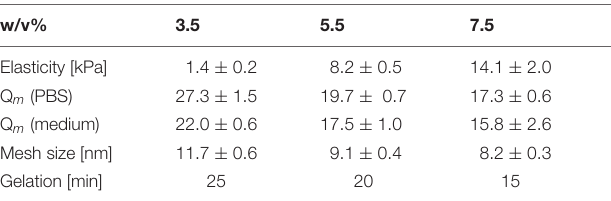
TABLE 2 | Elasticity, swelling ratio and mesh size for PEG/HA